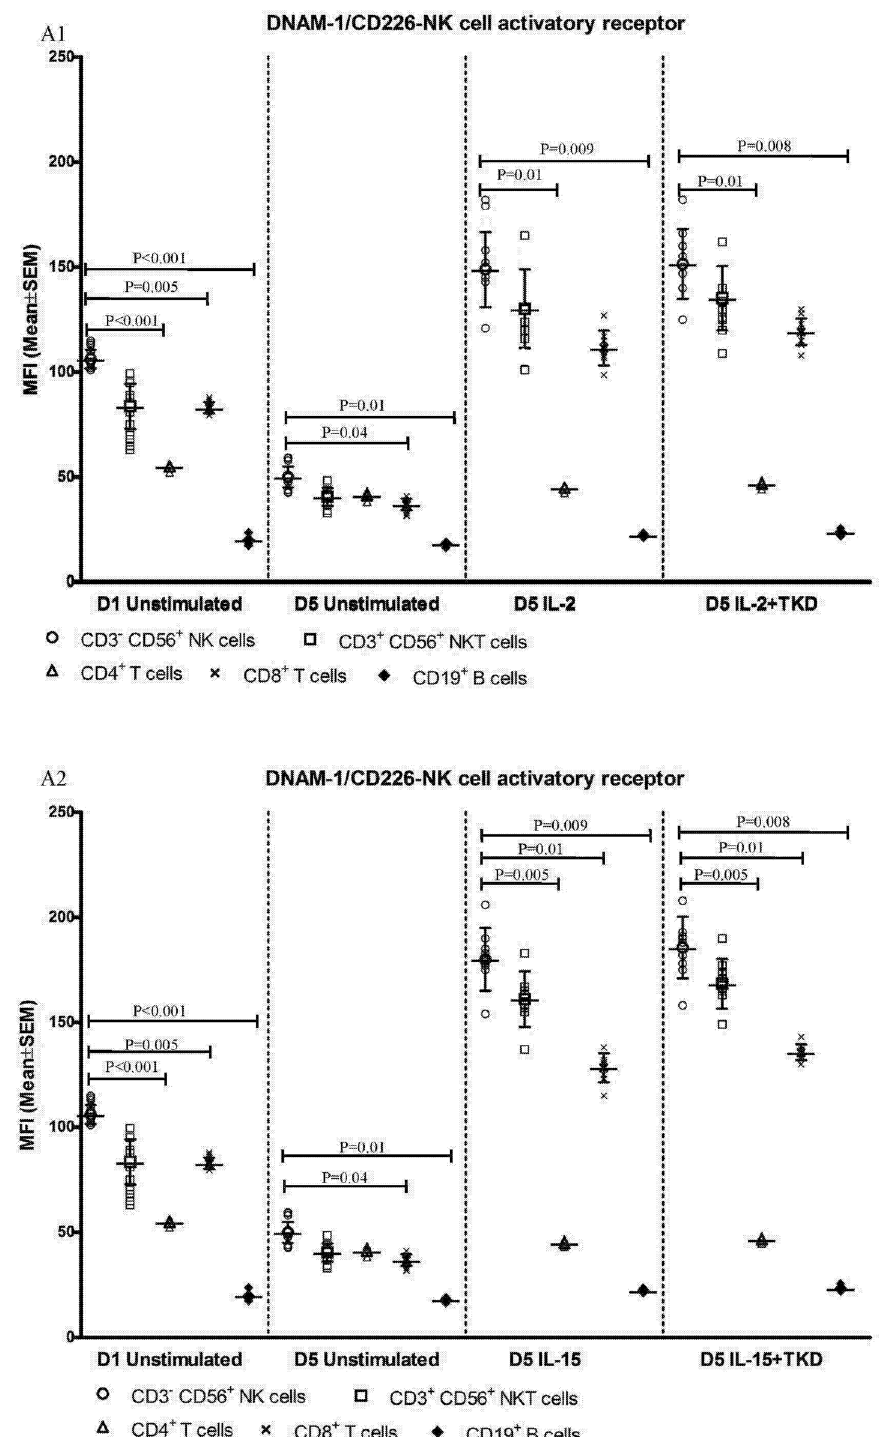
Fig 12. The effect of IL-2, IL-15, IL-2/TKD and IL-15/TKD on the expression of DNAM-1 in peripheral blood mononuclear cells of healthy individuals — the amount of receptor expressed by CD3 - CD56 + NK cells, CD3 + CD56 + NKT cells, CD4 + T cells, CD8 + T cells and CD19 + B cells (the median fluorescence intensity). The amount of DNAM-1 expressed by CD3 - CD56 + NK cells, CD3 + CD56 + NKT cells, CD4 + T cells, CD8 + T cells and CD19 + B cells was examined within the fraction of unstimulated and